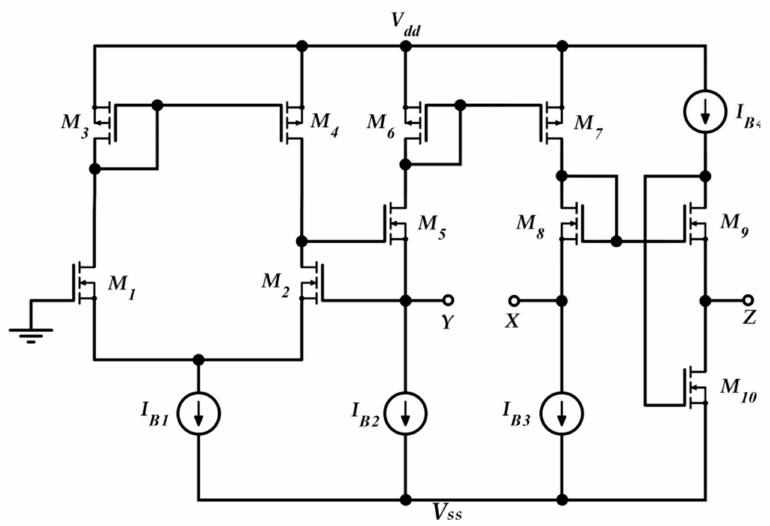
Figure 3. Transistor level implementation of the VCII + used in this